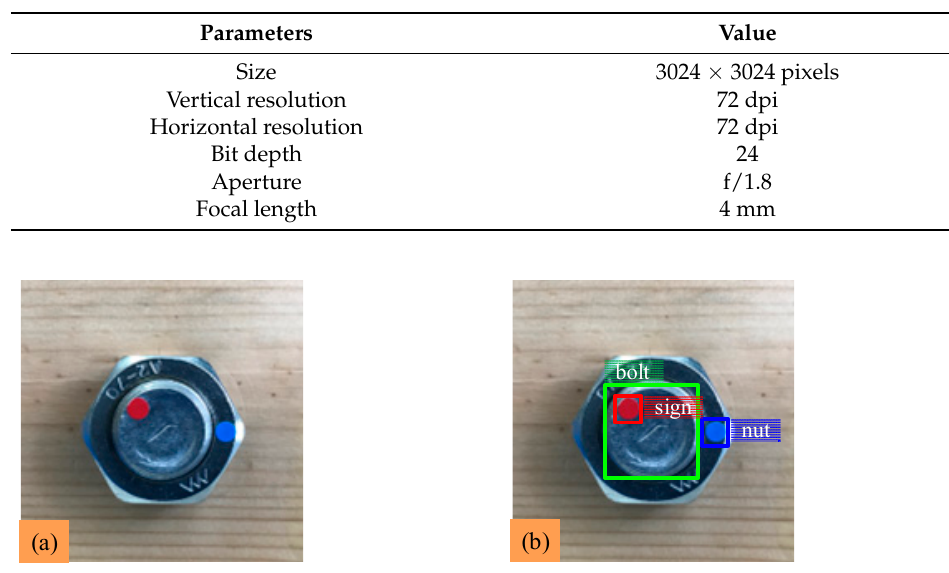
When a bolt is loosened, the ∠ A changes with the rotation angle of the ‘nut’ class, and the degree of the bolt loosening is determined by detecting the change of ∠ A . The change of ∠ A is ∆ . The expression of ∆ is shown in Equation (2).